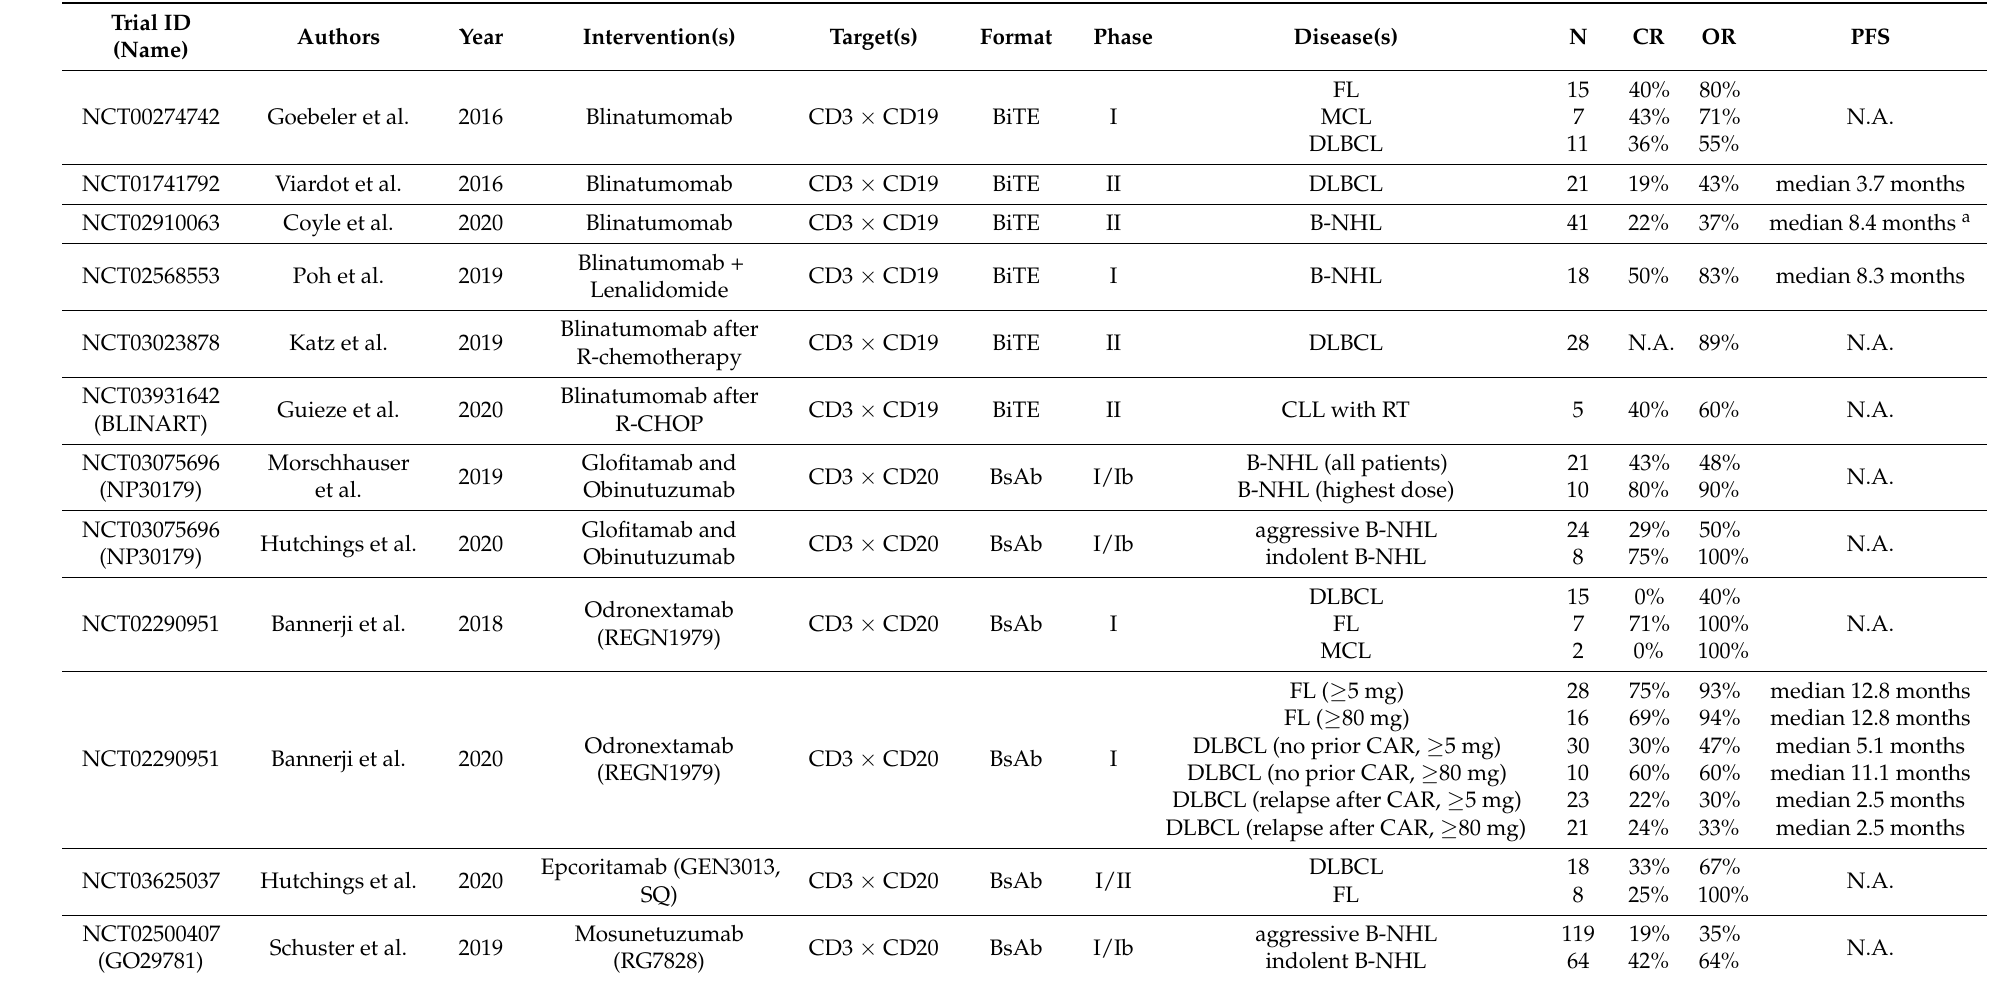
Table 8. Clinical trials of bispecific T-cell-engaging constructs in